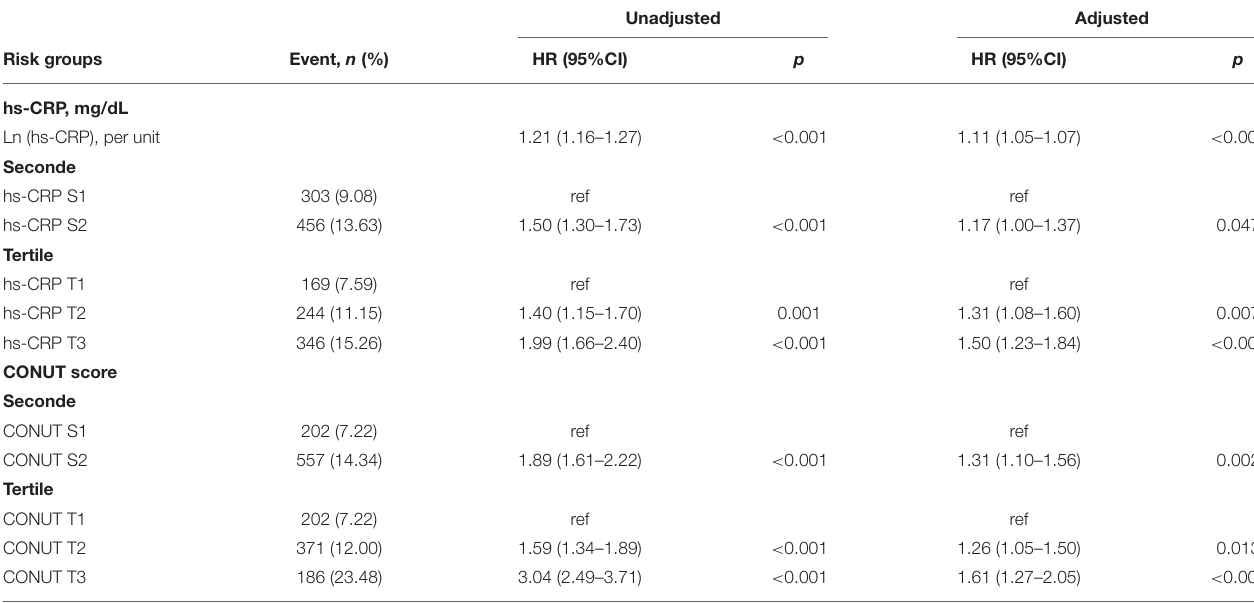
TABLE 2 | Inflammation and malnutrition in relation to all-cause mortality, respectively.